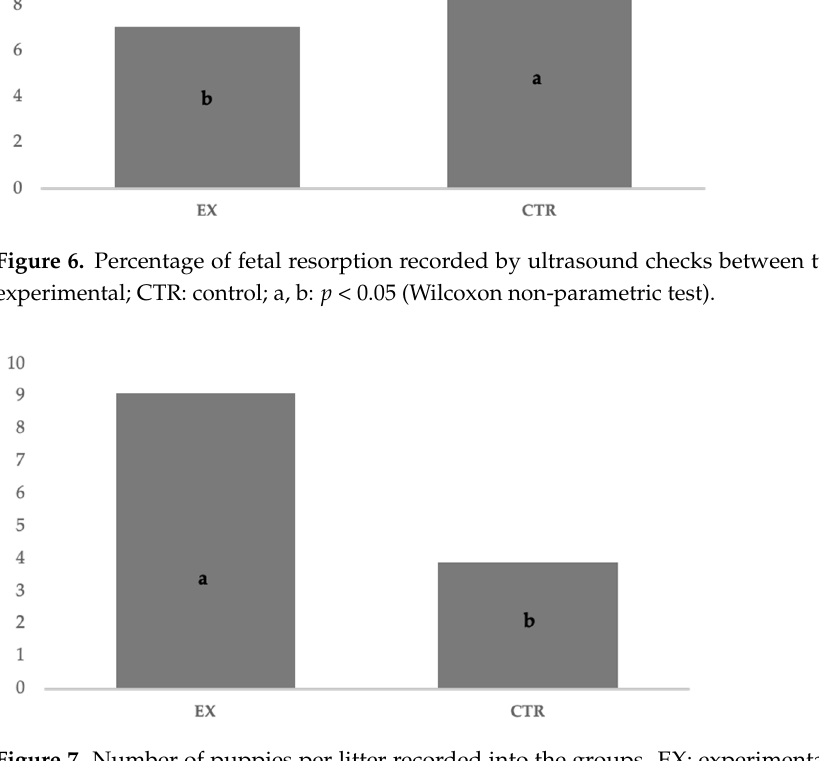
Figure 7. Number of puppies per litter recorded into the groups. EX: experimental; CTR: control; a, b: p < 0.05 (Wilcoxon non-parametric test).